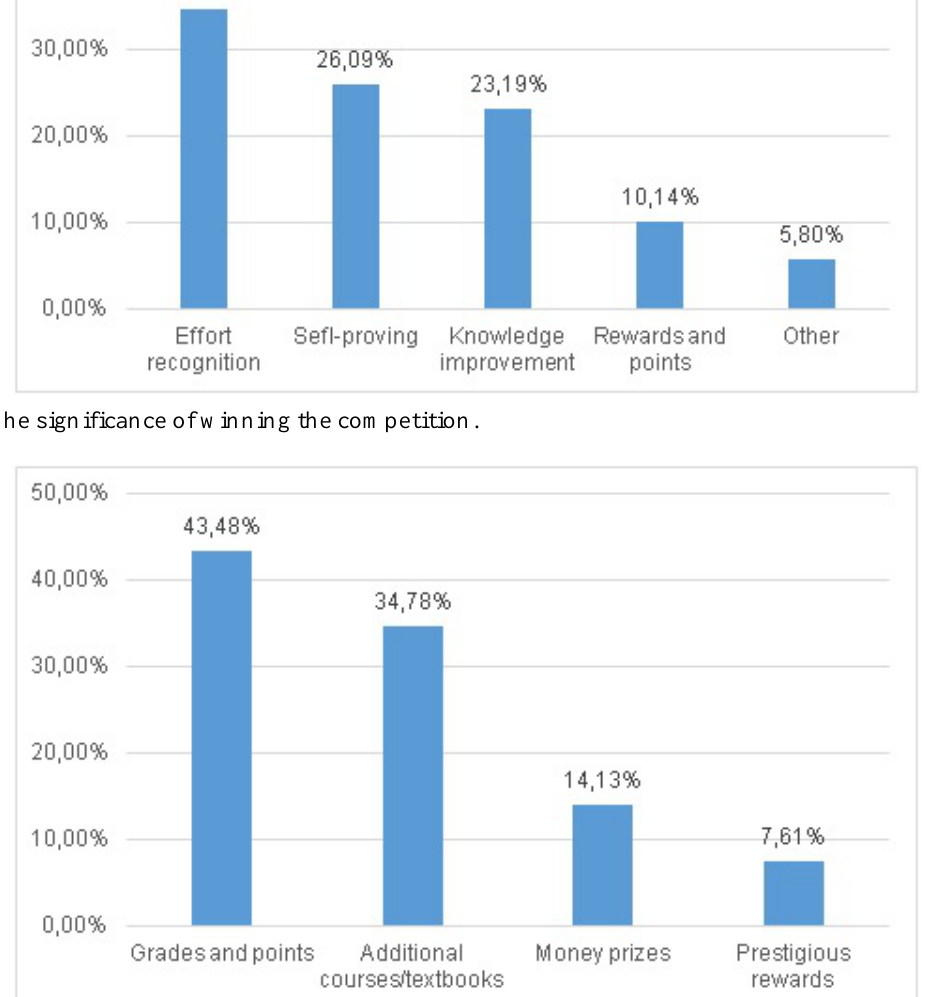
Figure 4. Rewards